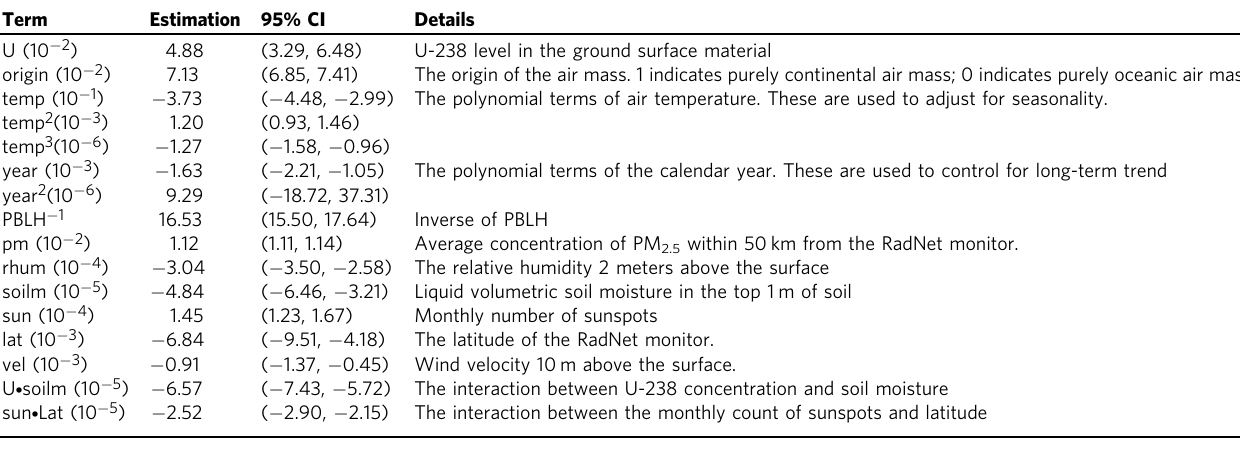
Table 2 The associations between PR and other environmental factors. Term Estimation 95% CI